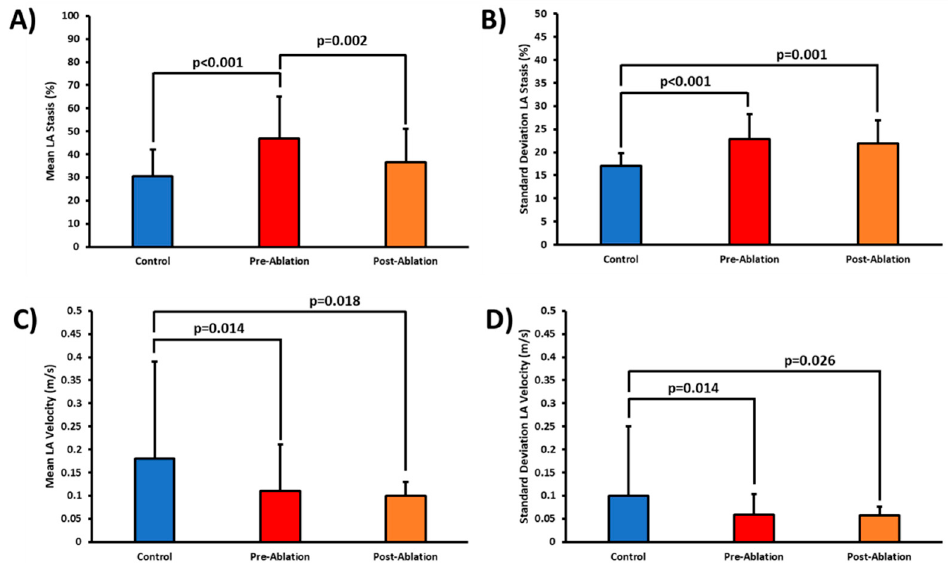
Figure 2. Left atrial stasis and velocity in controls, pre-ablation, and post-ablation patients. Panel ( A ) shows the comparison of all cohorts for mean left atrial (LA) stasis. Panel ( B ) shows the comparison of standard deviation LA stasis. Panels ( C ) and ( D ) show the comparison for all cohorts for mean and standard deviation LA velocity.